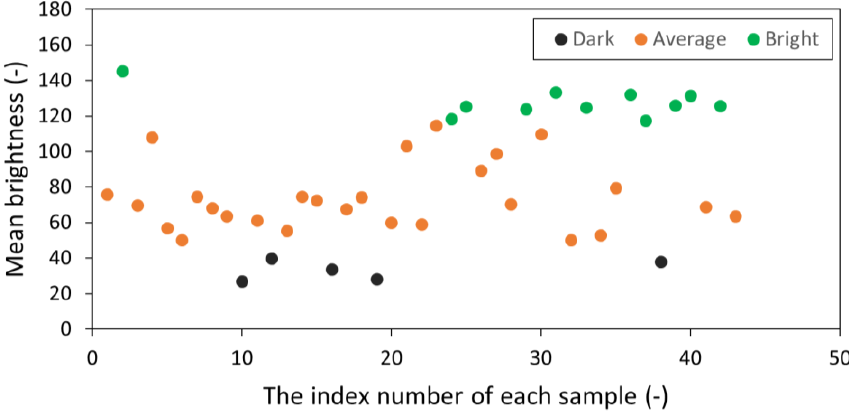
Figure 8. The brightness distribution in the greenhouse.